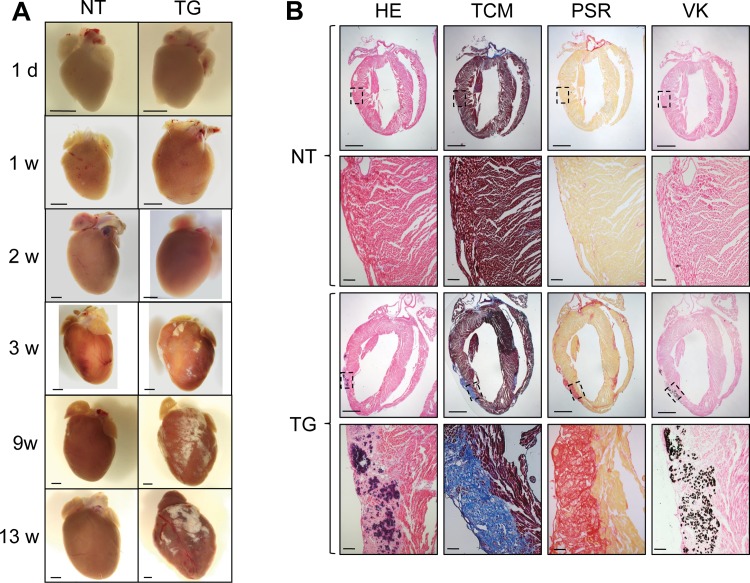
Structural analyses of transgenic mouse hearts.(A) Gross morphological analysis of transgenic and non-transgenic hearts (one day– 13 weeks). Of note, fibrosis was absent at day 1, week 1 and 2, but was present three weeks after birth. Scale bars represent 1 mm. (B) Histology of transverse sections of transgenic and non-transgenic hearts (9 weeks). HE = Haematoxilin and Eosin staining. TCM = Trichrome staining after Masson. PCR = Picro Sirius Red staining. VK = Von-Kossa staining. Scale bars represent 1 mm or 100 μm for the higher magnification. Of note, transgenic hearts demonstrate necrosis, extensive fibrosis and calcification mainly localized close to the epicardium.